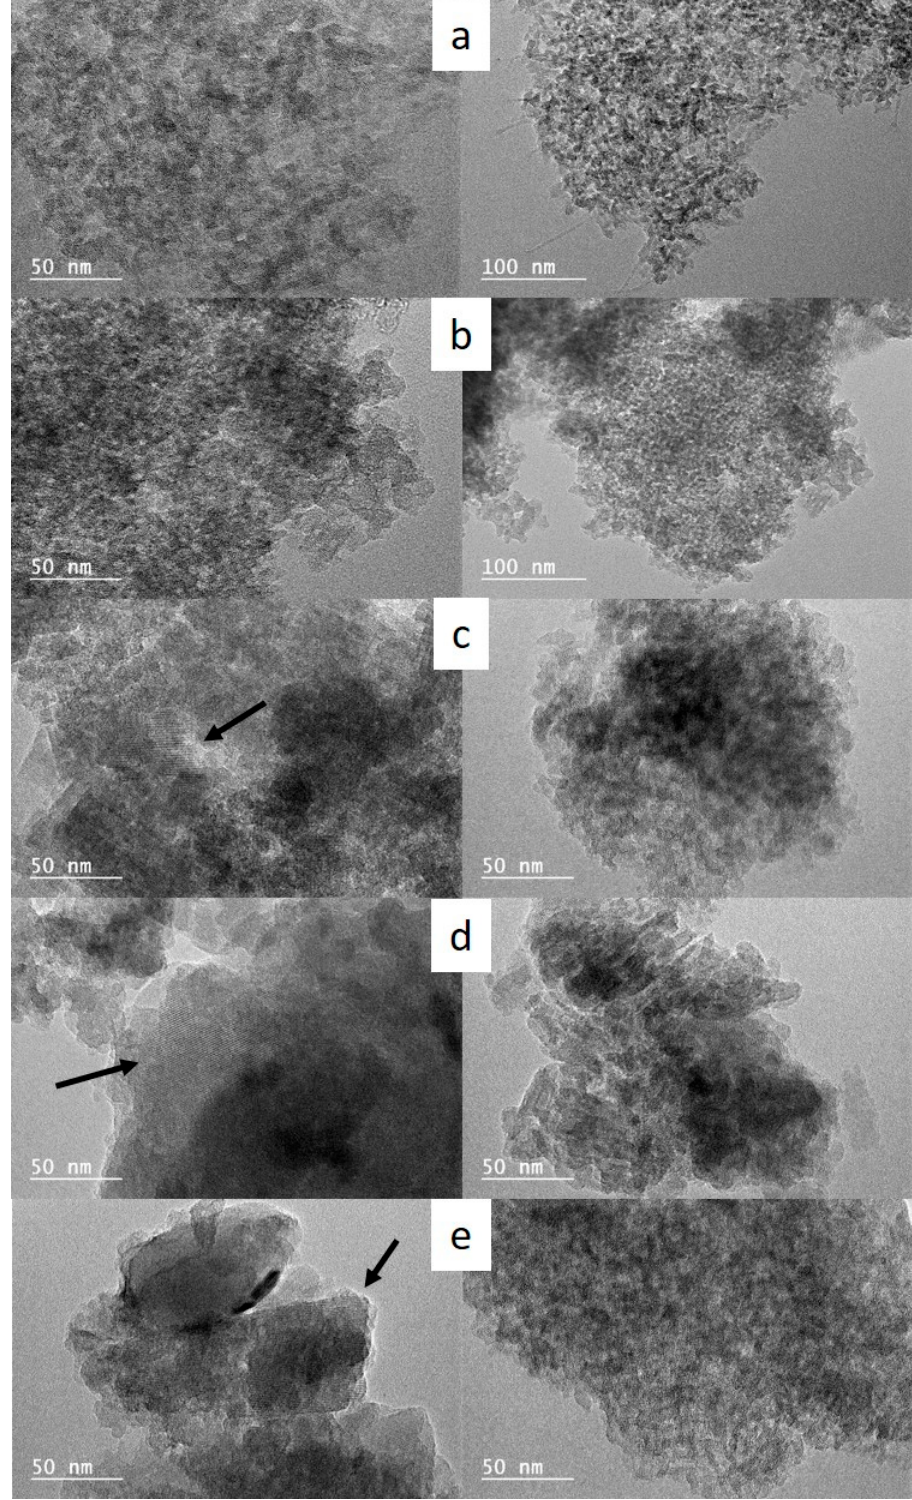
Figure 3. TEM images of ( a ) 4-S ( b ) 4-NS ( c ) 7-NS ( d ) 14-NS ( e ) 21-NS samples showing the morphology of the obtained hierarchized ZSM-12 zeolites (Black arrows indicate the presence of larger crystals).